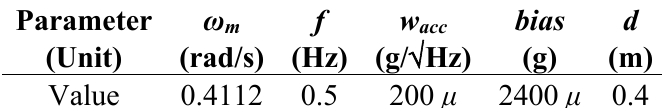
Table 1. Numerical values of the simulation parameters.